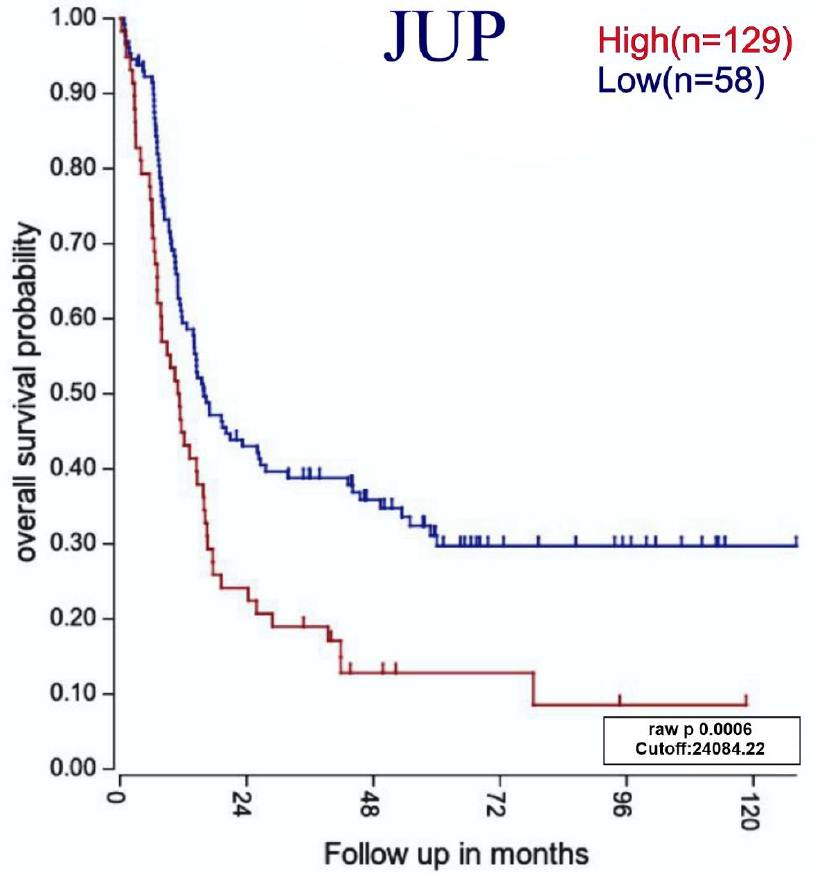
Figure 8. Overall survival probability analysis of JUP using data derived from microarray expressions of adults with B-ALL. Kaplan – Meier survival curves represent the relationship of the probability of survival over time (measured in months) divided into high- and low-expressing groups. The cutoff point was calculated according to expression level (raw) for separate individuals with high (red) and low (blue) gene expressions.